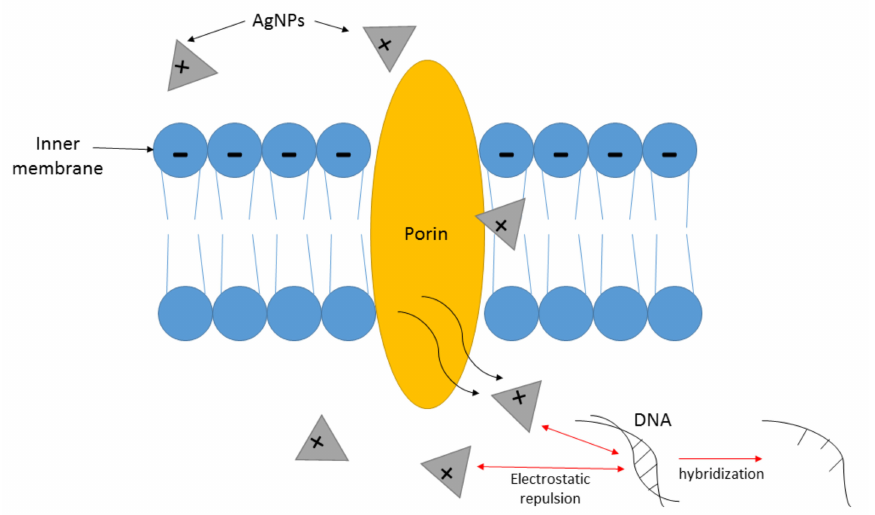
Figure 4. The mechanism of action of AgNPs affected through membrane penetration assisted by electrostatic repulsion and hybridization.